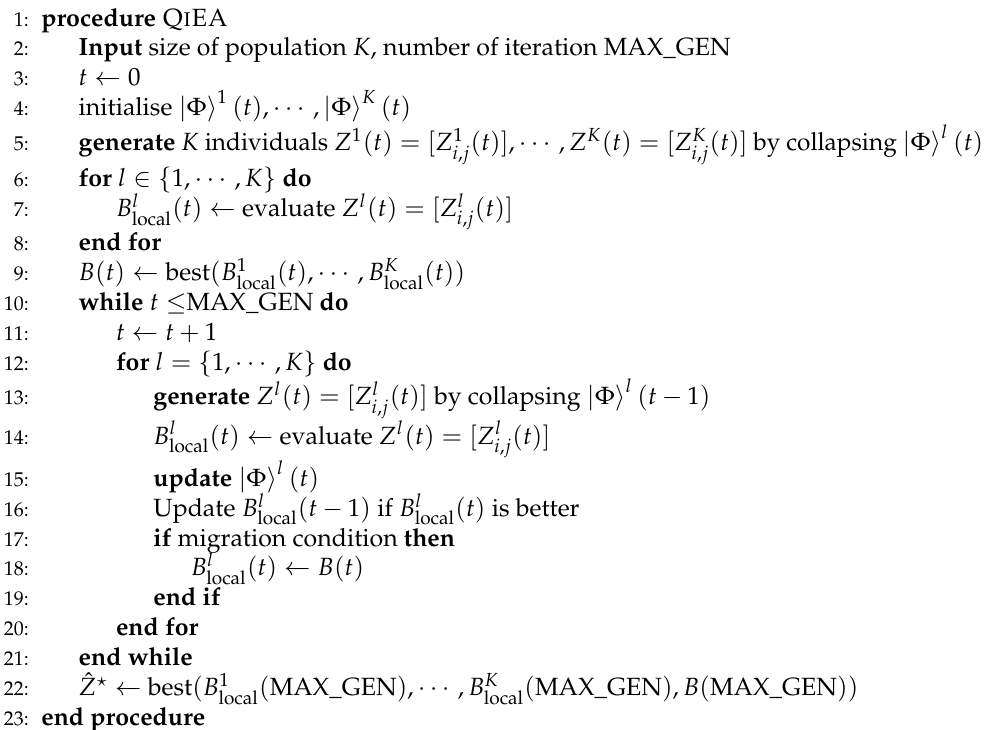
Algorithm 1 QiEA algorithm for service-matching